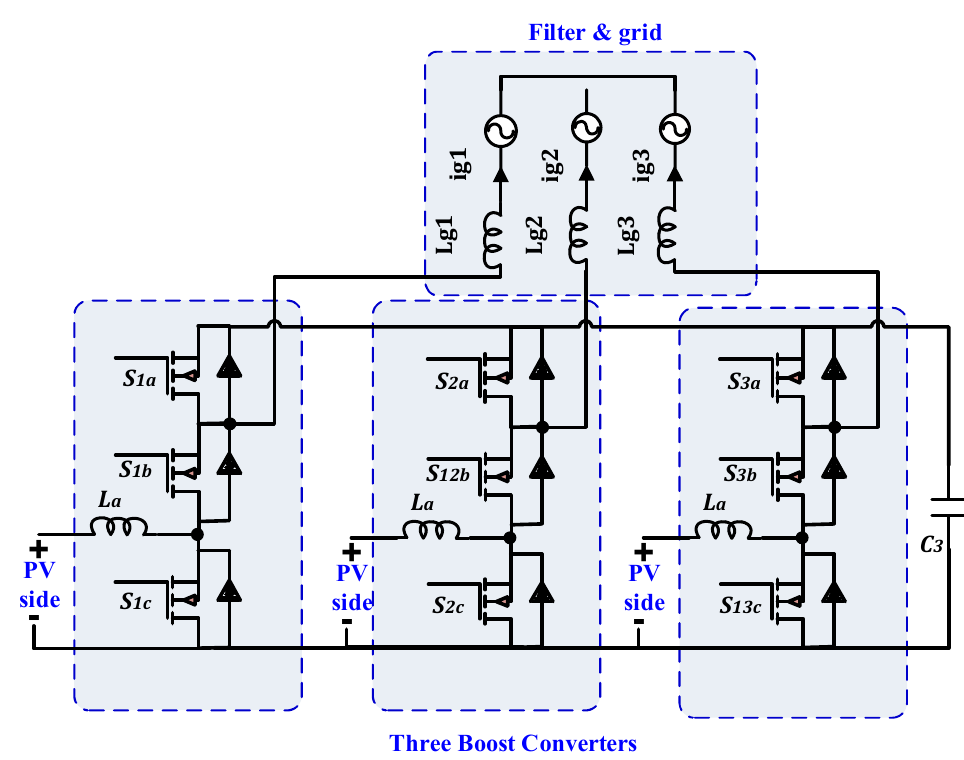
Figure 24. Multi-input three-phase two stages VSI